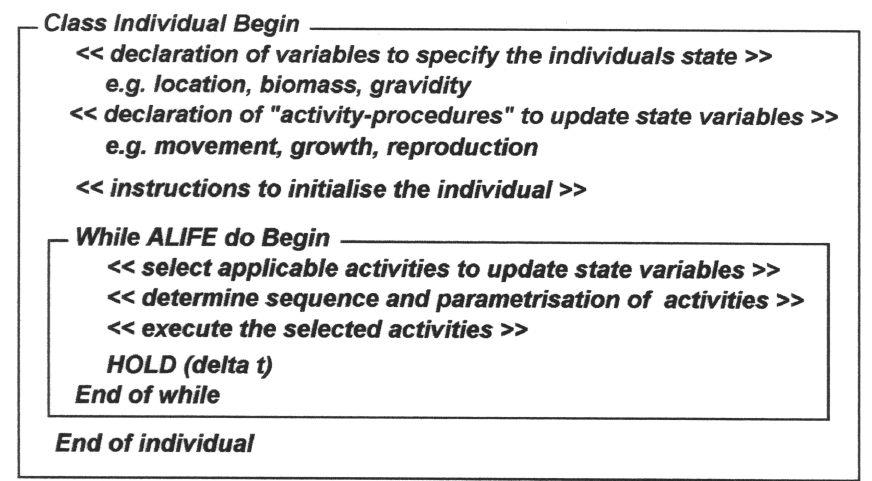
FIGURE 1. General structure representing an individual using an object-oriented modelling approach: The class specifies the general structure. During simulation, various copies (objects), which act as independent entities, can be started. The internal loop is a central data structure that is repeated as long as the object is considered (cid:147)alive.(cid:148) This loop updates the state variables of the objects according to the applicable instructions for the specific situation and the specification of the interval until the next updating round ((cid:147)Hold(cid:148)). One of the activities can be reproduction (i.e., starting an object of the same